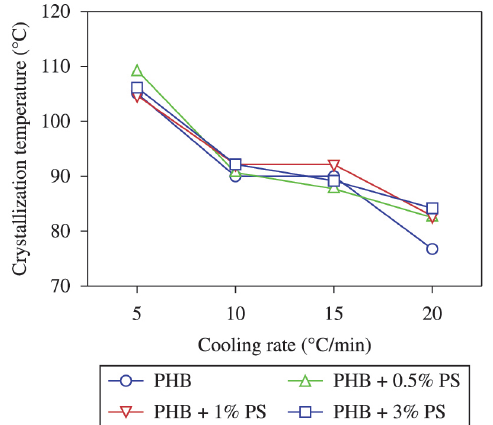
Figure 2. Crystallization peak temperature of PHB and PHB/PS blends as a function of cooling rate.